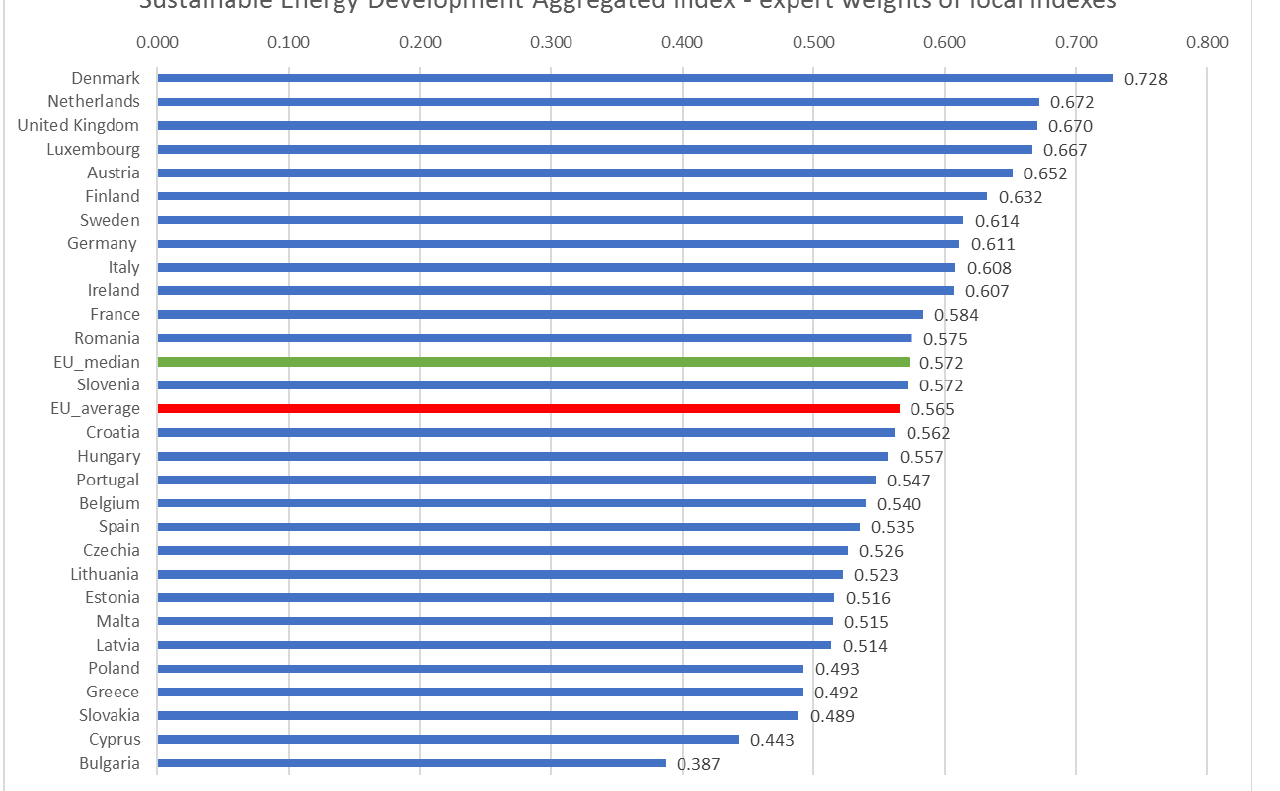
Figure 7. Comparison of SEDAI in 2017 for the EU-28 Member States calculated with the use of equal and expert weighting of indexes for social, economic and environmental dimensions.